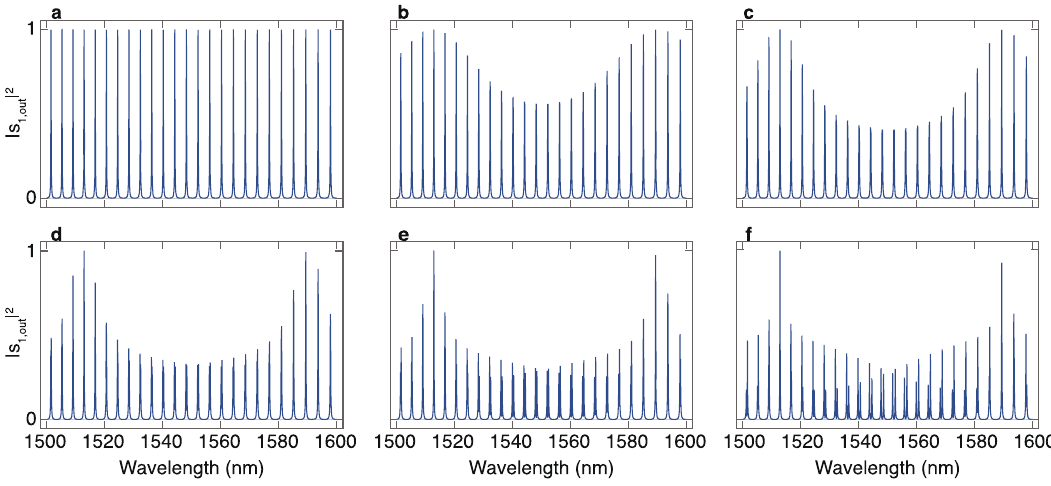
Fig. 8 | Thetransmission spectrum ofcascaded-mode resonators withresidual back-re fl ection. Visualization of ( ∣ s 1,out ∣ 2 ) with s in = a – f ,equals r =10 ( − 6) , r =0.001, r =0.003, r =0.01, r =0.03, r =0.1,respectively.Small valuesof r translateintoanamplitudemodulationofthespectrum.Forlargevalues